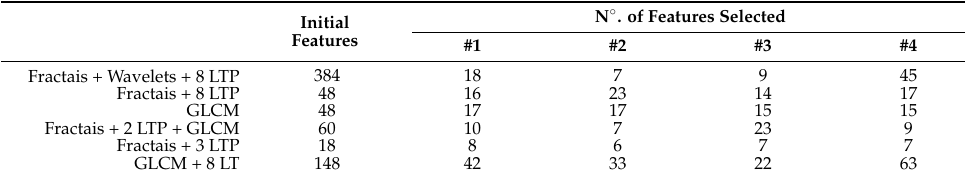
Table 12. Reduction in the number of